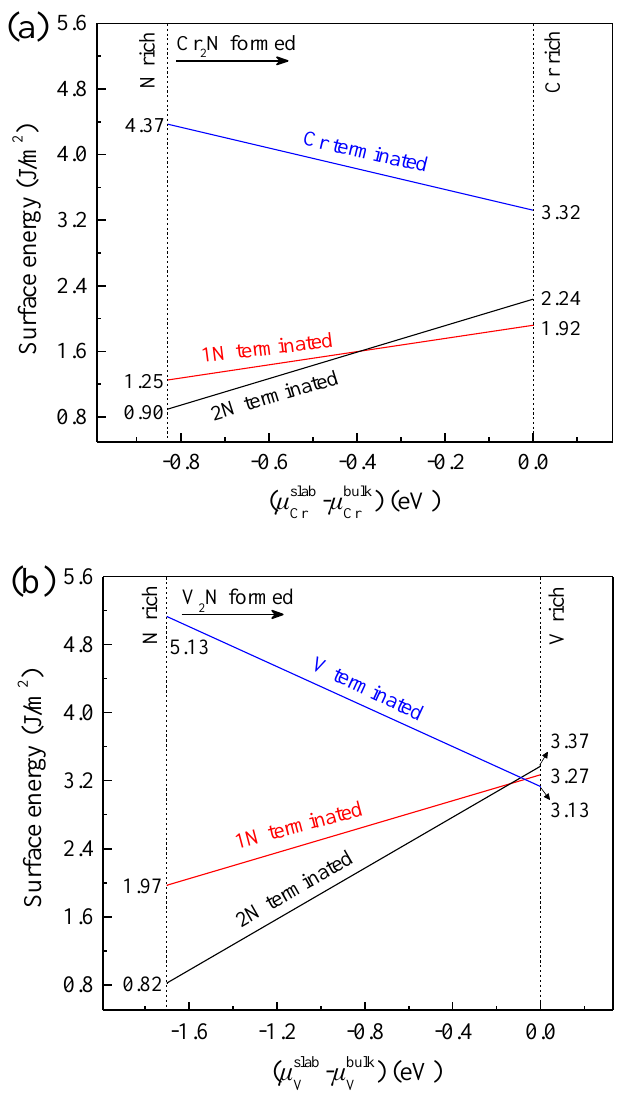
Figure 2. ( a ) Cr 2 N(0001) and ( b ) V 2 N(0001) surface energy as a function of chromium chemical potential ( μ slab − μ bulk ) and vanadium chemical potential ( μ slab Cr Cr The M/Cr 2 N and M/V 2 N interface models were built in the same way because the lattice constants of Cr 2 N and V 2 N are approximate. Here, the softer M slabs are stretched to align with Cr 2 N and V 2 N slabs. Interfacial mismatch rates are calculated according to the change of lattice constant of the M slabs [26]. The calculated results of interfacial mismatch rates for the M/Cr 2 N and M/V 2 N interface models are illustrated in Figure 4, and they are unanimously less than 7%. Therefore, the interface models constructed in this work represent valid